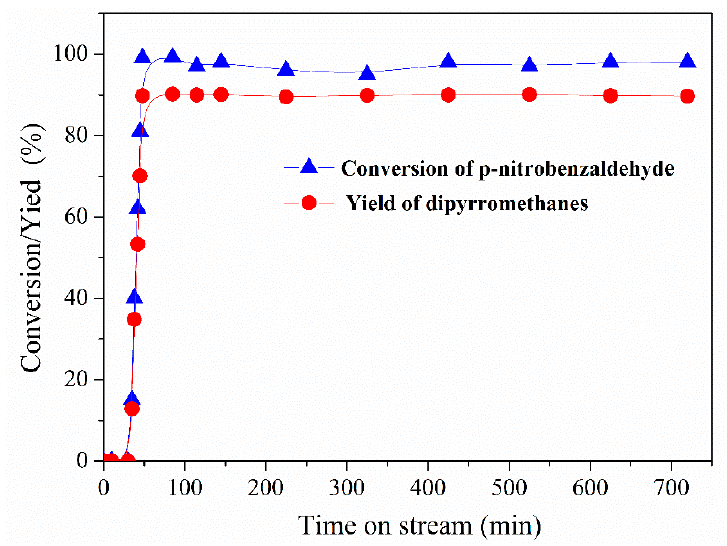
Figure 9. Conversion of p-nitrobenzaldehyde and the yield of 2,2 (cid:48) -(4-nitrophenyl) dipyrromethane in the Pickering-emulsion-based packed-bed